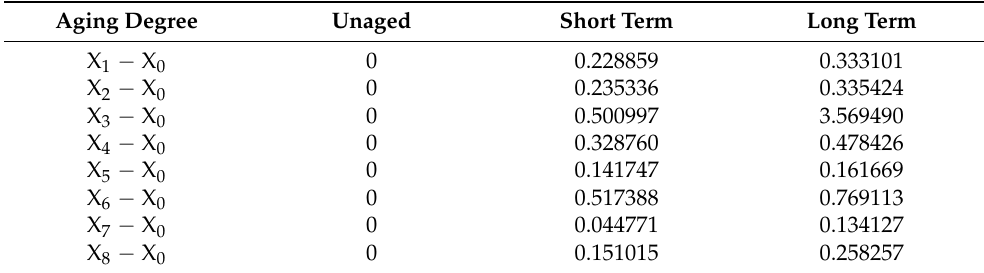
Table 8. Calculation of the absolute value of the difference between X 0 and X i .